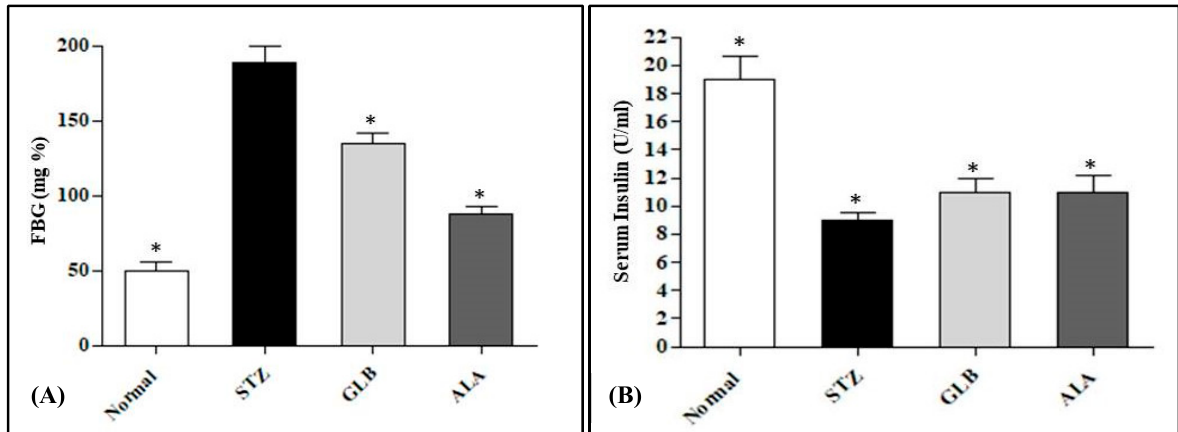
Figure 4. Effect of intraperitoneal injection of 20 mg/kg/day of C. aethiopica leaf total methanol extract (CAL) and 600 μ g/kg/day glibenclamide (GLB) on FBG ( A ) and serum insulin ( B ) levels in STZ-induced diabetic rats. Data are measured in triplicates (n = 3) and presented as means ± S.E.M. * Significantly different from the STZ-treated group at p < 0.05; FBG was assessed using a glucose oxidase kit; serum insulin was determined by an immunoassay kit.